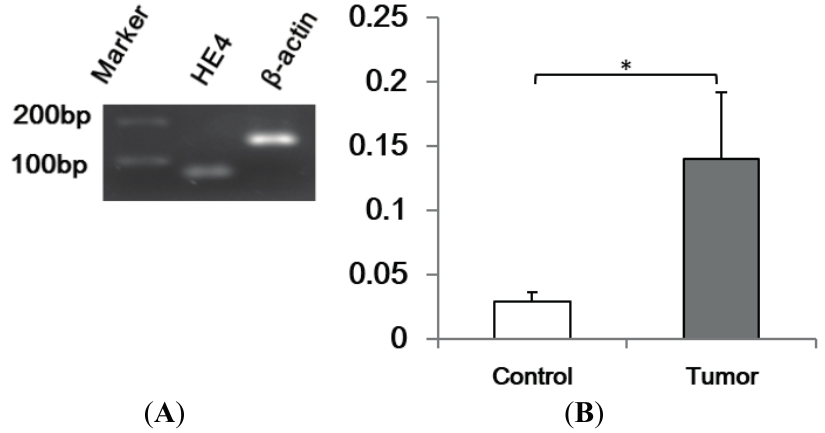
Figure 1. Human epididymis protein 4 (HE4) is over-expressed in pancreatic adenocarcinoma. Total RNA were extracted from pancreatic adenocarcinoma and adjacent tissues, and reverse transcription and real-time PCR were performed. ( A ) Real-time PCR final products were resolved in 2% agarose gel. The amplicon with single band pattern at predicted sizes (HE4, 68 bp; β -actin, 145 bp) indicates specific amplification of cDNA by real-time PCR. β -actin was used as an internal control; ( B ) The average HE4 mRNA levels were 4.8-fold higher in adenocarcinoma group (tumor) than the adjacent tissues group (Control) (* p <